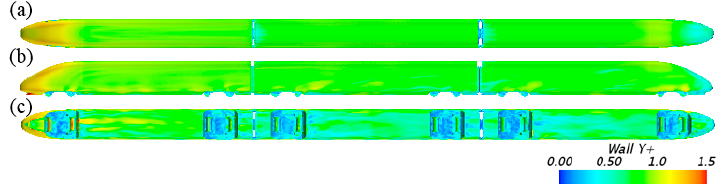
Figure 4. Medium grid: ( a ) plane at y = 0, ( b ) prism layer, and ( c ) train surface.